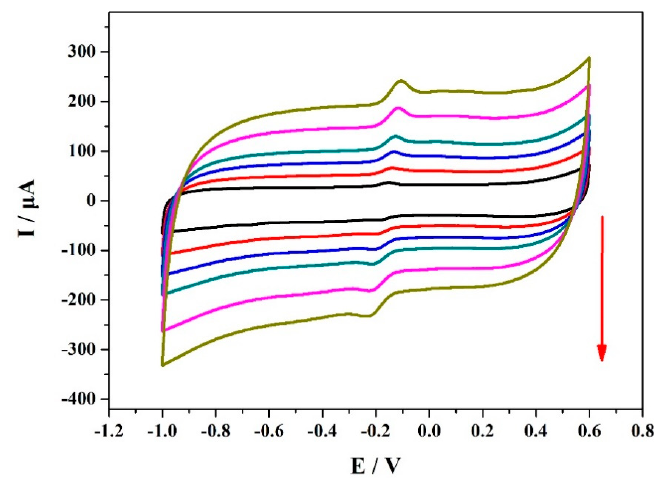
Figure 6. CV curves of 0.1 mM MP in PBS (0.1 M, pH 7.0) and the electrochemical sensor based on the VXC-72R/ZrO2/GCEs at different scan rates.